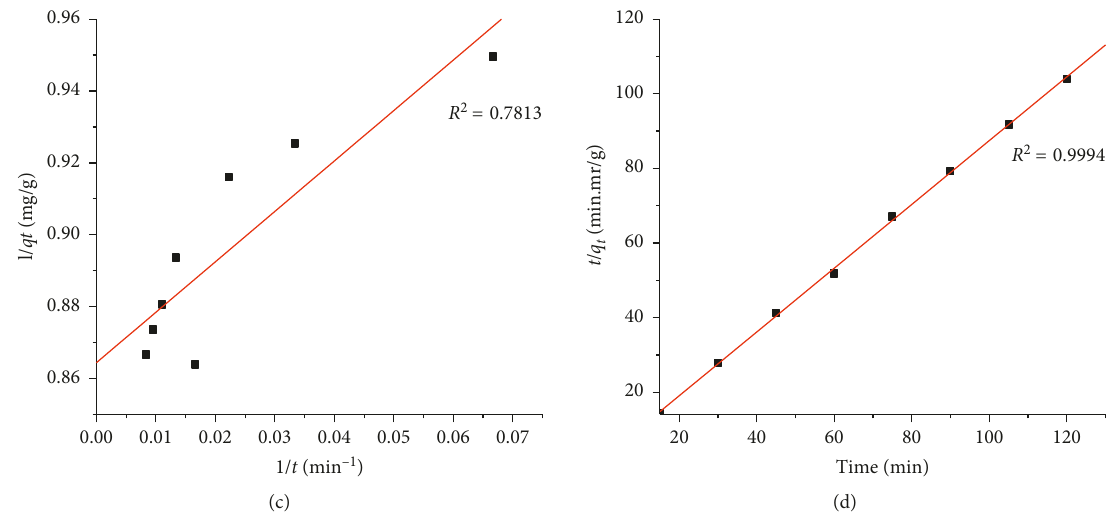
Figure 9: (a) Freundlich isotherm; (b) Langmuir isotherm; (c) pseudo-first-order kinetics; (d) pseudo-second-order kinetics. Table 2: Results of kinetic experiments conducted for industrial dye using calcined egg shell powder. First-order kinetics